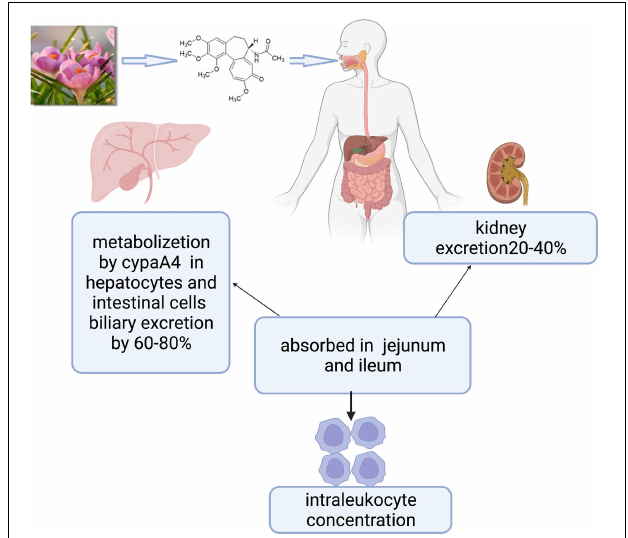
FIGURE 1 | Colchicine is the active principle derived from colchicum autumnale plants whose formula is C22H25NO6, including three rings. Colchicine is absorbed in the jejunum and ileum, metabolized mainly by the CYP3A4 in the liver and intestine, and cleared by bile and kidney. Biological effects are mainly related to intraleukocyte